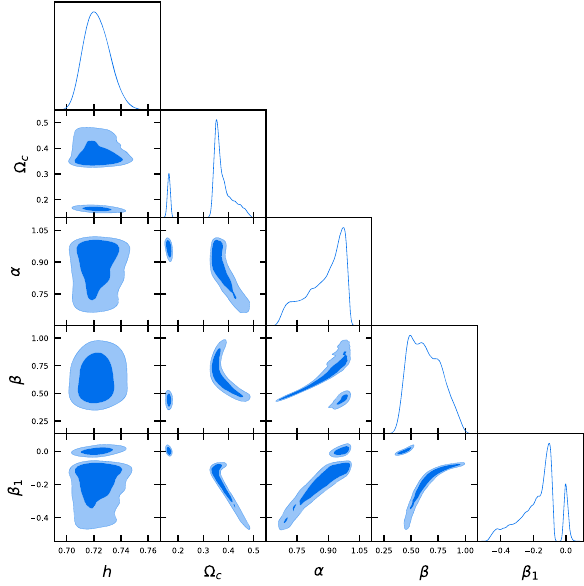
Fig. 1 Contour plots for model IMHRDE1 showing the 1 σ and 2 σ regions. We considered the full joint analysis with Pantheon + CC + R19 + BAO + CMB